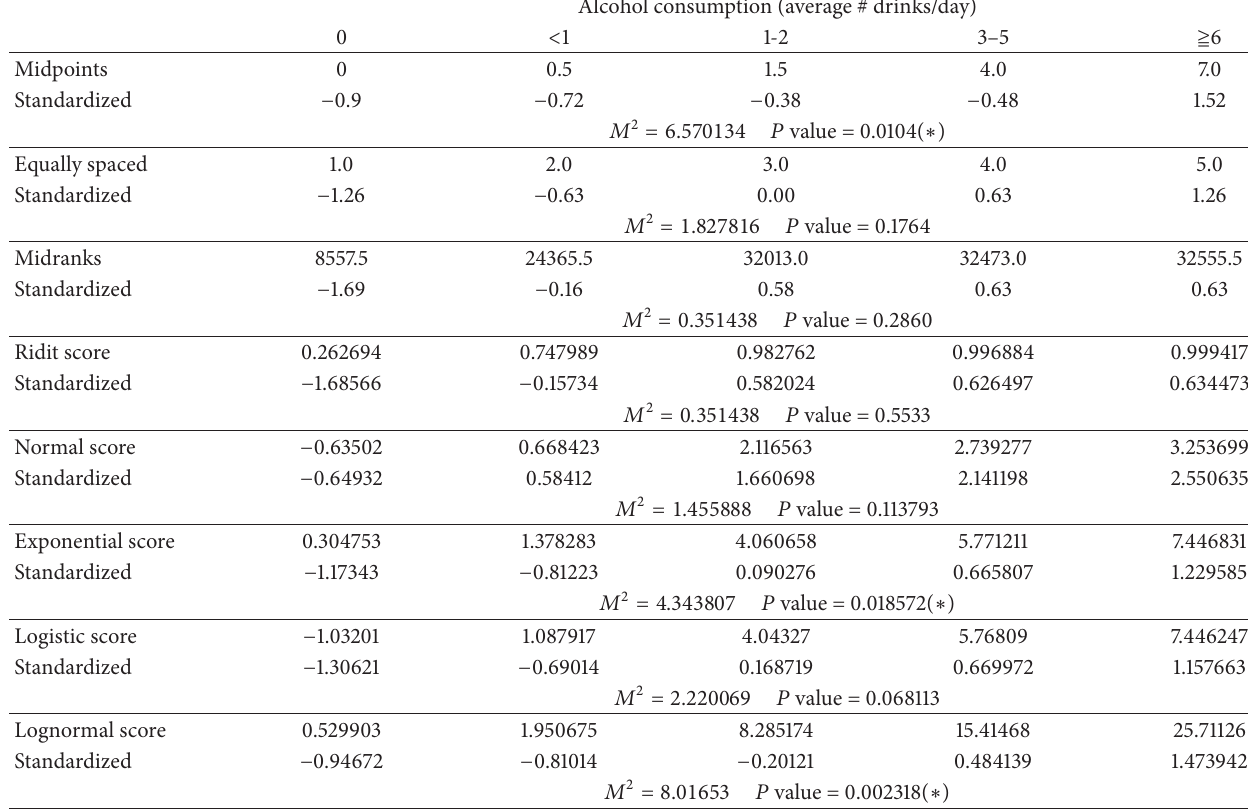
Table 2: Alternative scoring systems for ordinal categories with exact one-sided 𝑃 values.